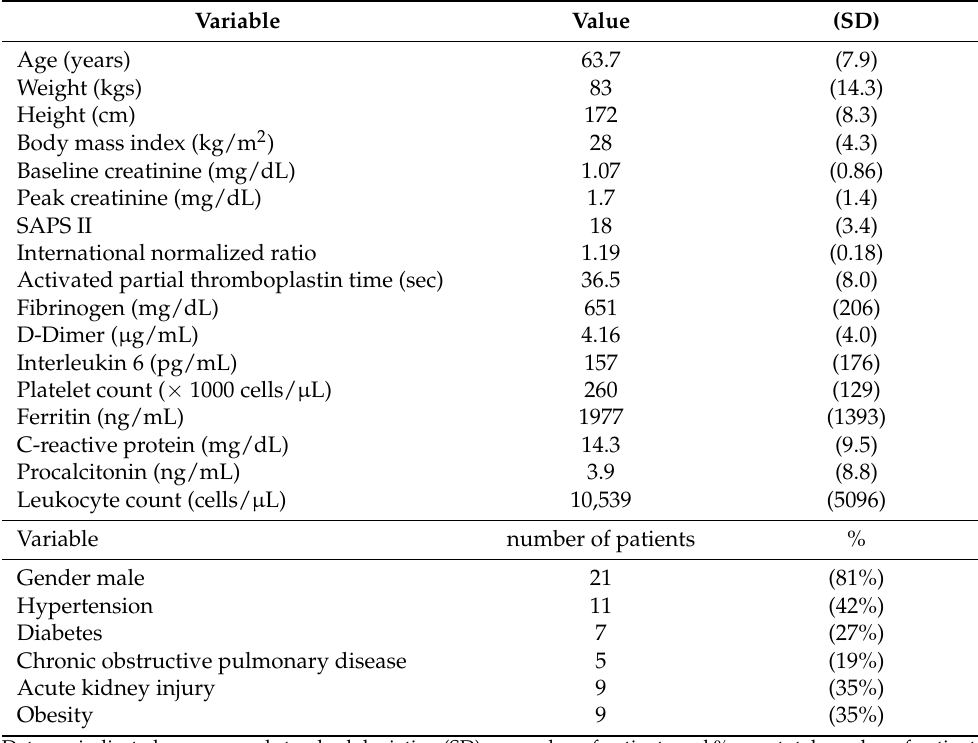
Table 1. Clinical and laboratory characteristics of the patient population (n =